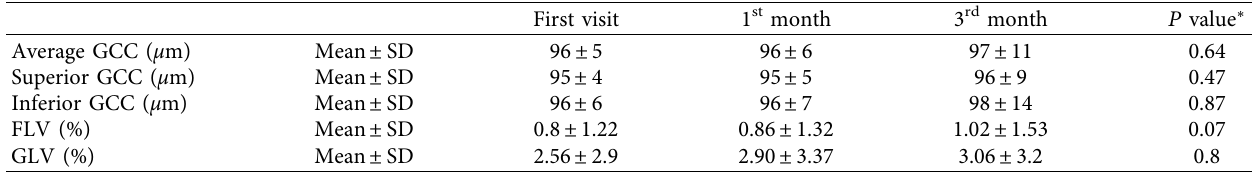
Figure 1: Representative spectral-domain optical coherence tomography images of the optic nerve head and peripapillary retinal nerve fiber layer thickness of two patients (a, b) at baseline and 1 and 3 months after COVID-19 recovery denoted by 0, 1, and 3. Table 2: Ganglion cell complex analysis over the study